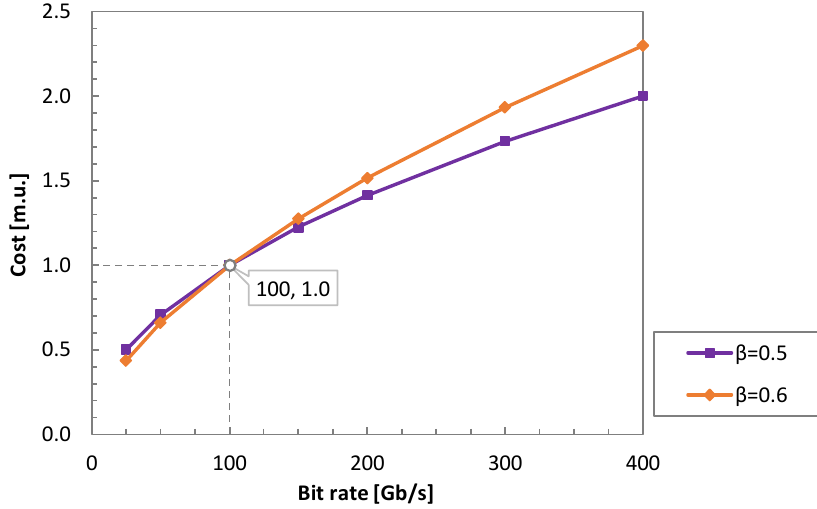
Figure 11. Cost profile for lightpath transceivers.